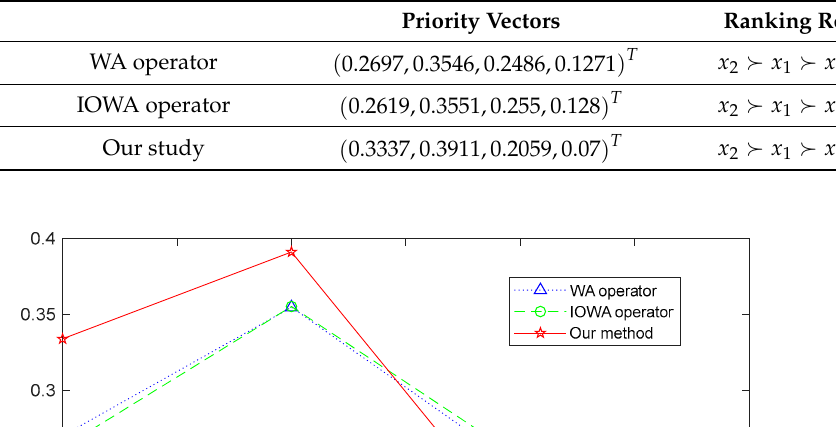
Table 4. Comparison results for three methods.